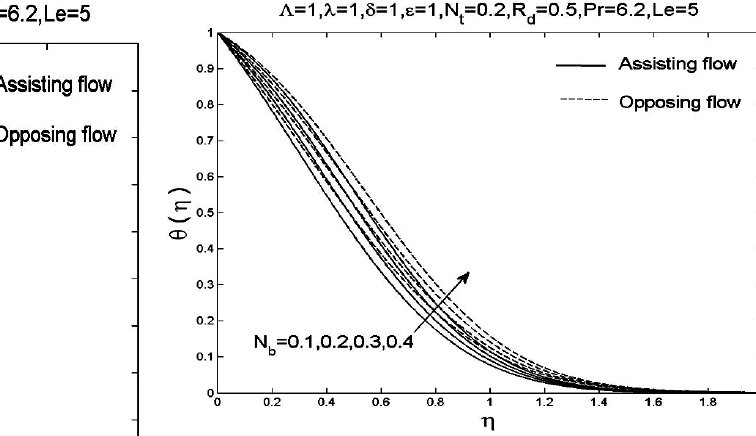
Fig. 15. The effect of the thermophoresis parameter Nt on the temperature profiles ( ) θη